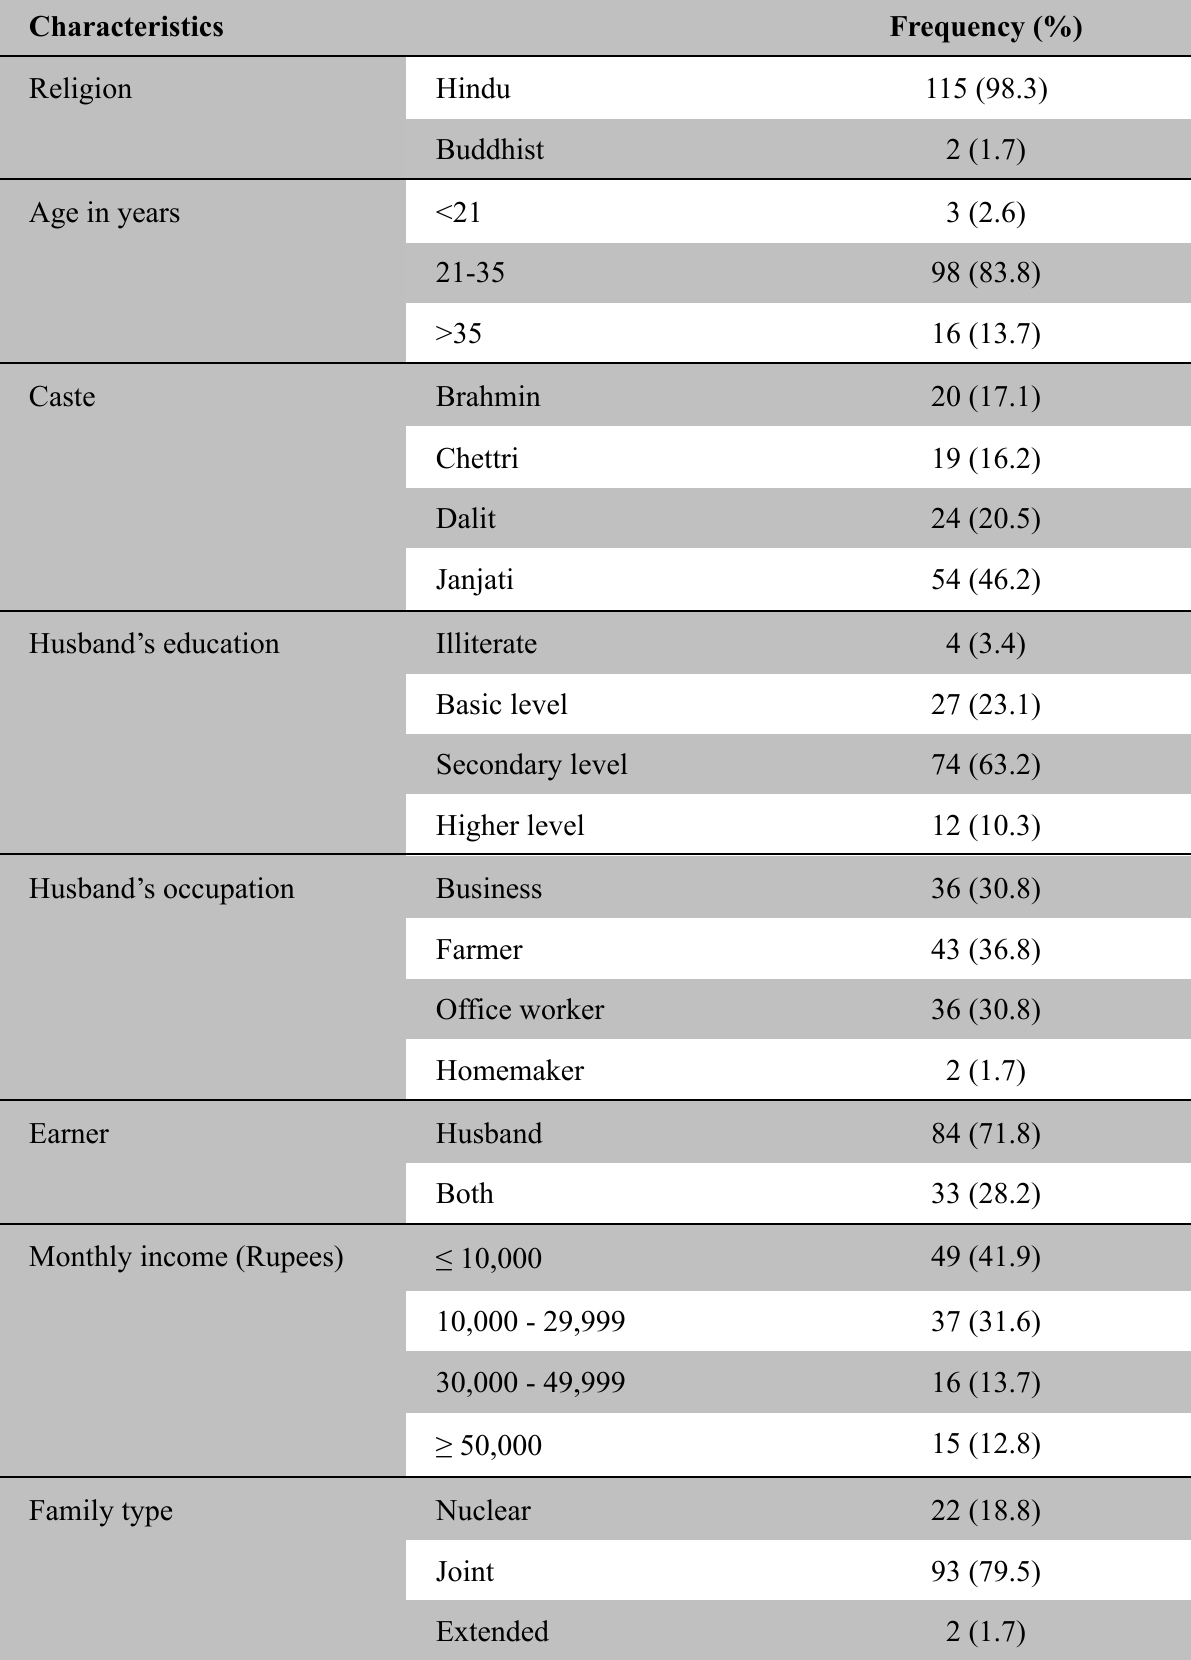
Table 1: Sociodemographic variables of the respondents (n=117)